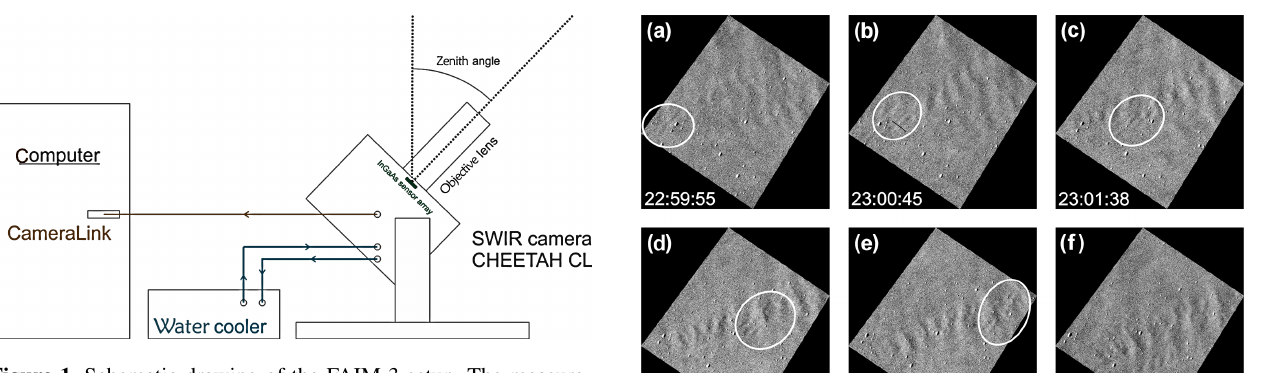
Figure 1. Schematic drawing of the FAIM 3 setup. The measure- ment configuration with a zenith angle of 46 ◦ is shown here.